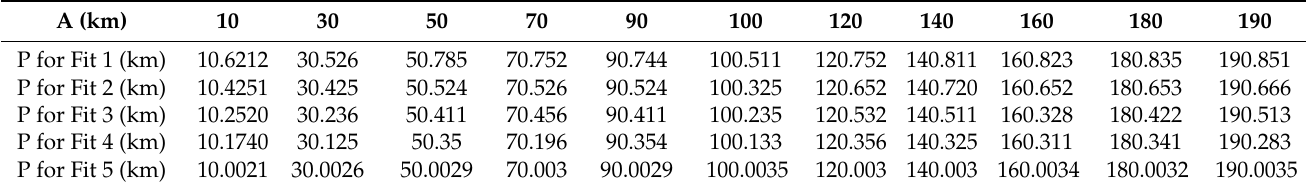
Table 11. Actual (A in km) and predicted (P in km) fault locations under LLL fault scenario.